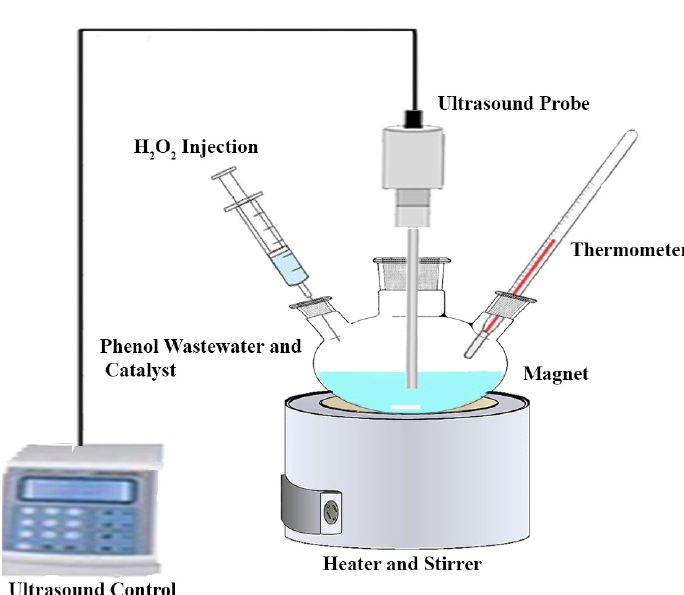
Fig. 2. The Experimental setup for wet catalytic evaluation of Fe-ZSM-5 in the decomposition of